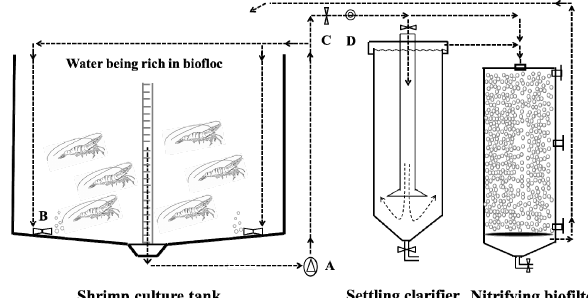
Figure 1. Schematic diagram of a hybrid biofloc-based recirculating aquaculture system (biofloc-RAS) combining in situ biofloc technology and ex situ biofilter for the intensive culture of L. vannamei . Dotted arrows indicate the water flow through the system. Water was pumped from the culture tank by running a circulating pump; most of the water circulated to the culture tank through water injectors; the rest of the water in-flowed into a settling clarifier and then a nitrifying biofilter and lastly returned to the culture tank by gravity. The water entering the clarifier and biofilter was adjusted by regulating valves at water flow rates of 0.42-1.68 m 3 h -1 . ( A ) circulating pump, ( B ) water injector, ( C ) regulating valve, ( D ) flow-meter. RAS, recirculating aquaculture system.